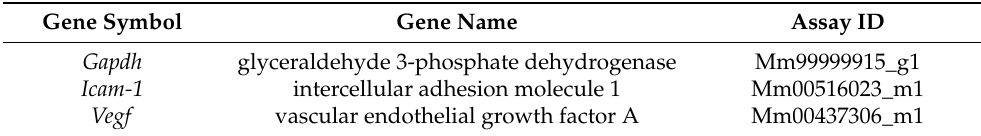
Table 1. List of TaqMan assays (Thermo Scientific) used in this study. Gene